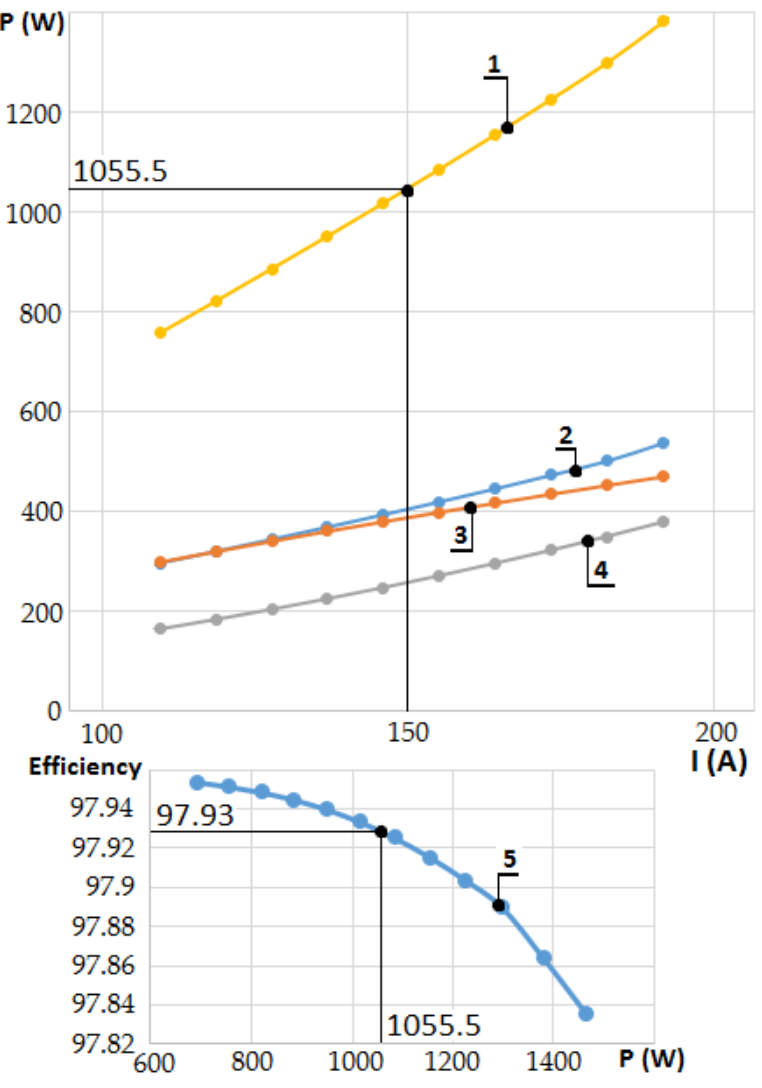
Figure 9. Boost mode of operation. 1–DC–DC power stage losses; 2–Boost transistor Q2 switching and conductive losses (IGBT module M1); 3–Boost diode D2 losses (IGBT module M1); 4–Buck transistor Q1 losses, permanently switched ON (IGBT module M2); 5–Efficiency.